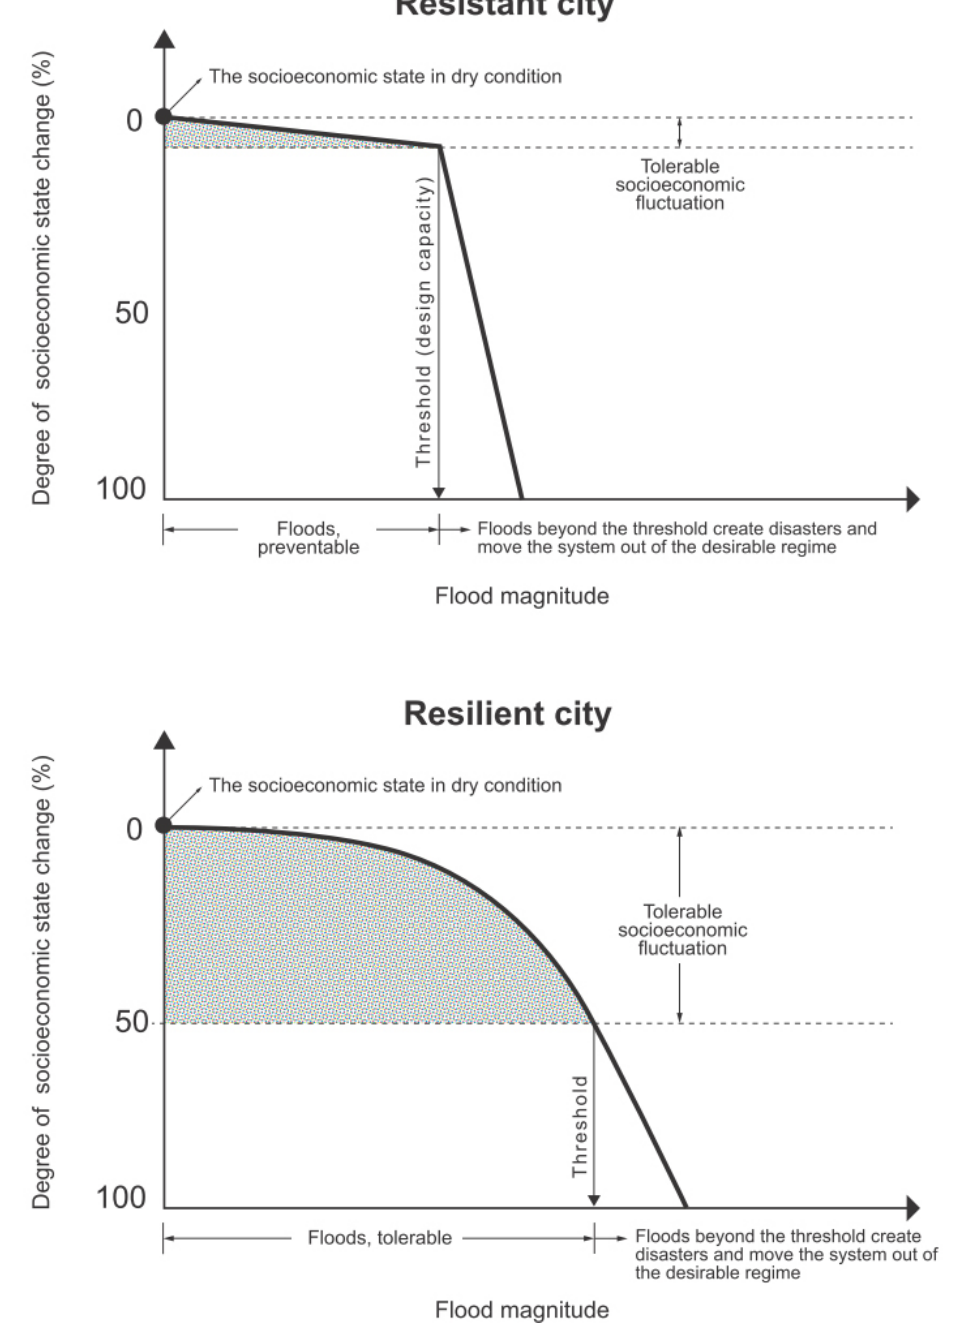
Fig. 4 . A comparison between the resistant and resilient city. The resistant city is dependent on flood-control infrastructure, functioning only in the dry conditions and having little tolerance of socioeconomic state changes, i.e., narrow tolerable range. This leads to a small basin of attraction of the desirable regime, whose size is indicated by the shaded area; hence low urban resilience to floods. On the contrary, the resilient city tolerates flooding and much greater fluctuation in socioeconomic conditions, thus having a larger basin and consequentially greater urban resilience to